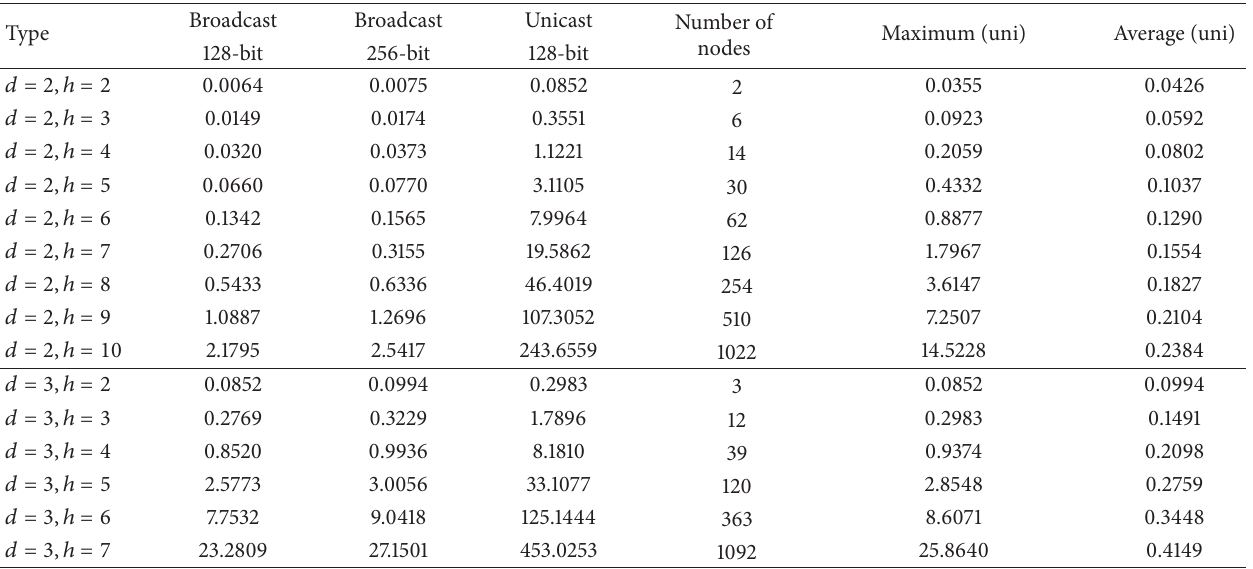
Table 2: Communication overheads, unit is mJ.